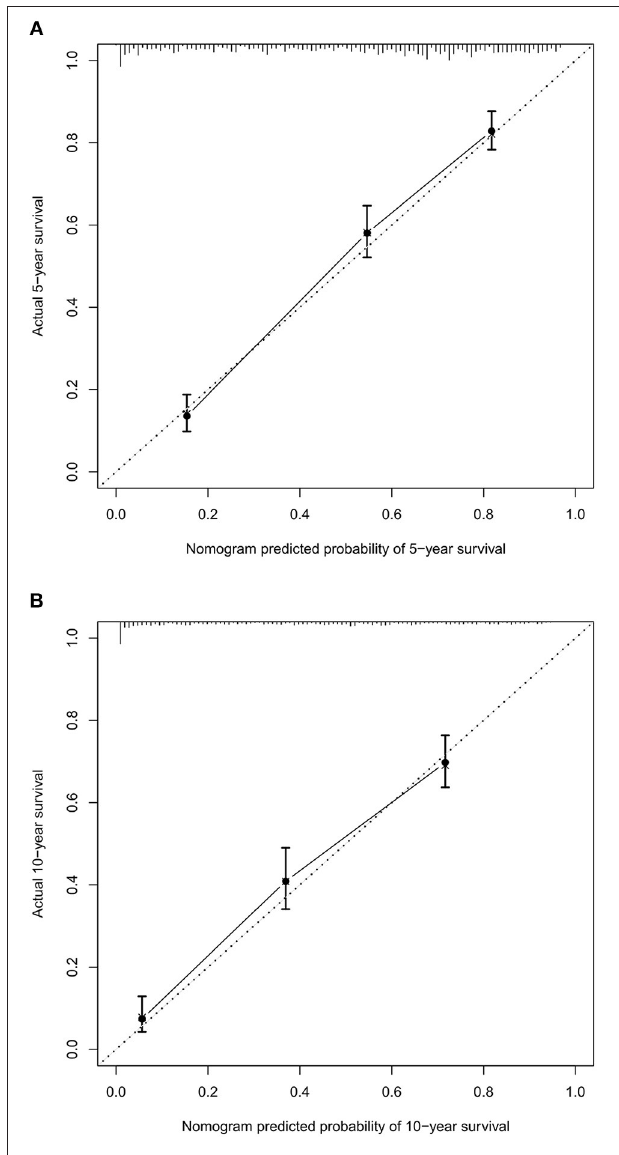
FIGURE 4 | The calibration curve for predicting patient survival at 5- (A) and 10-years (B) . Nomogram predicted probability of cancer-specific survival (CSS) is plotted on the x -axis, actual CSS is plotted on the y